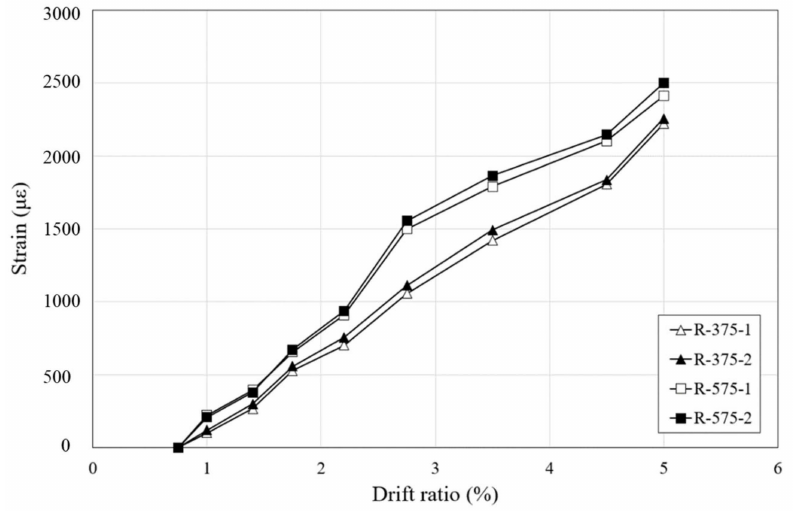
Figure 12. Strain-drift ratio curves of RSL